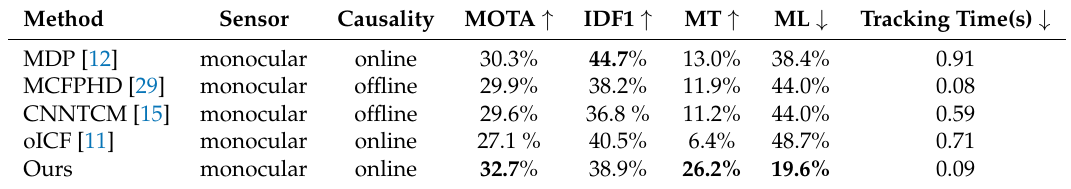
Table 5. Comparison with state-of-the-art methods on the testing subset of MOT2015